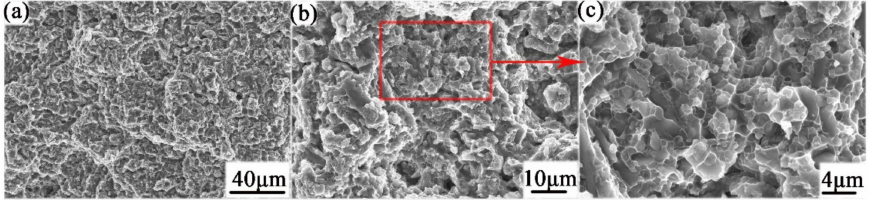
Figure 12. SEM/SE micrograph of fracture surface with compaction energy 1885 J, ( a – c ) with differ- ent